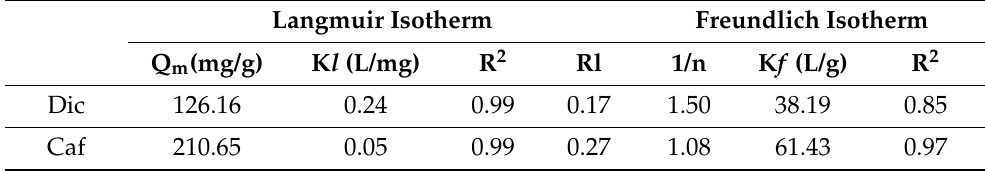
Table 5. Parameters of Langmuir and Freundlich models of Dic and Caf onto AC based on argan shells.